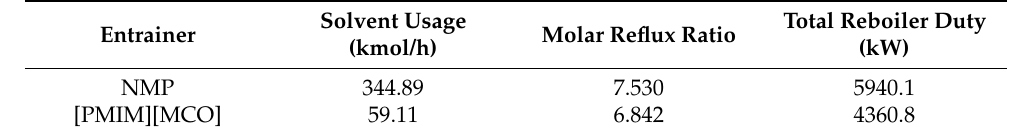
Table 2. Optimized operating conditions and total energy consumptions of the ED process using NMP and [PMIM][MCO] as entrainers.